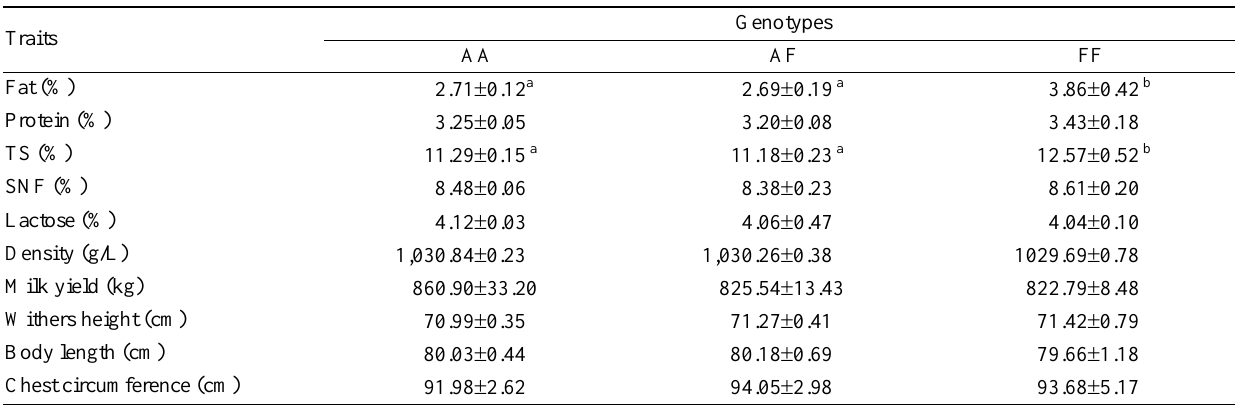
Table 3. Associations of polymorphism at CSN1S2 gene L2 locus with economic traits in dairy goats Traits